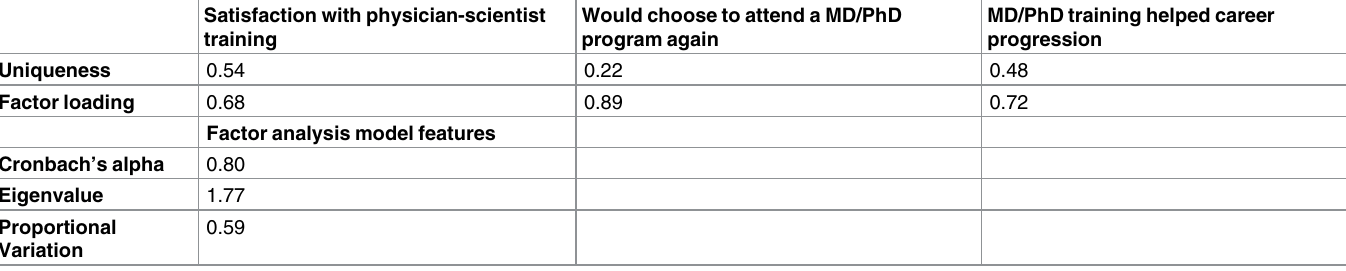
Table 2. Summaryfindings derived from factor analysis for the three outcome variables and a summaryof the model features. Likert responses from 135 MD/PhD programgraduateswho answeredall three questionswere analyzedto confirm the one factor structure and quantify the reliabilityof mea- suring MD/PhD program